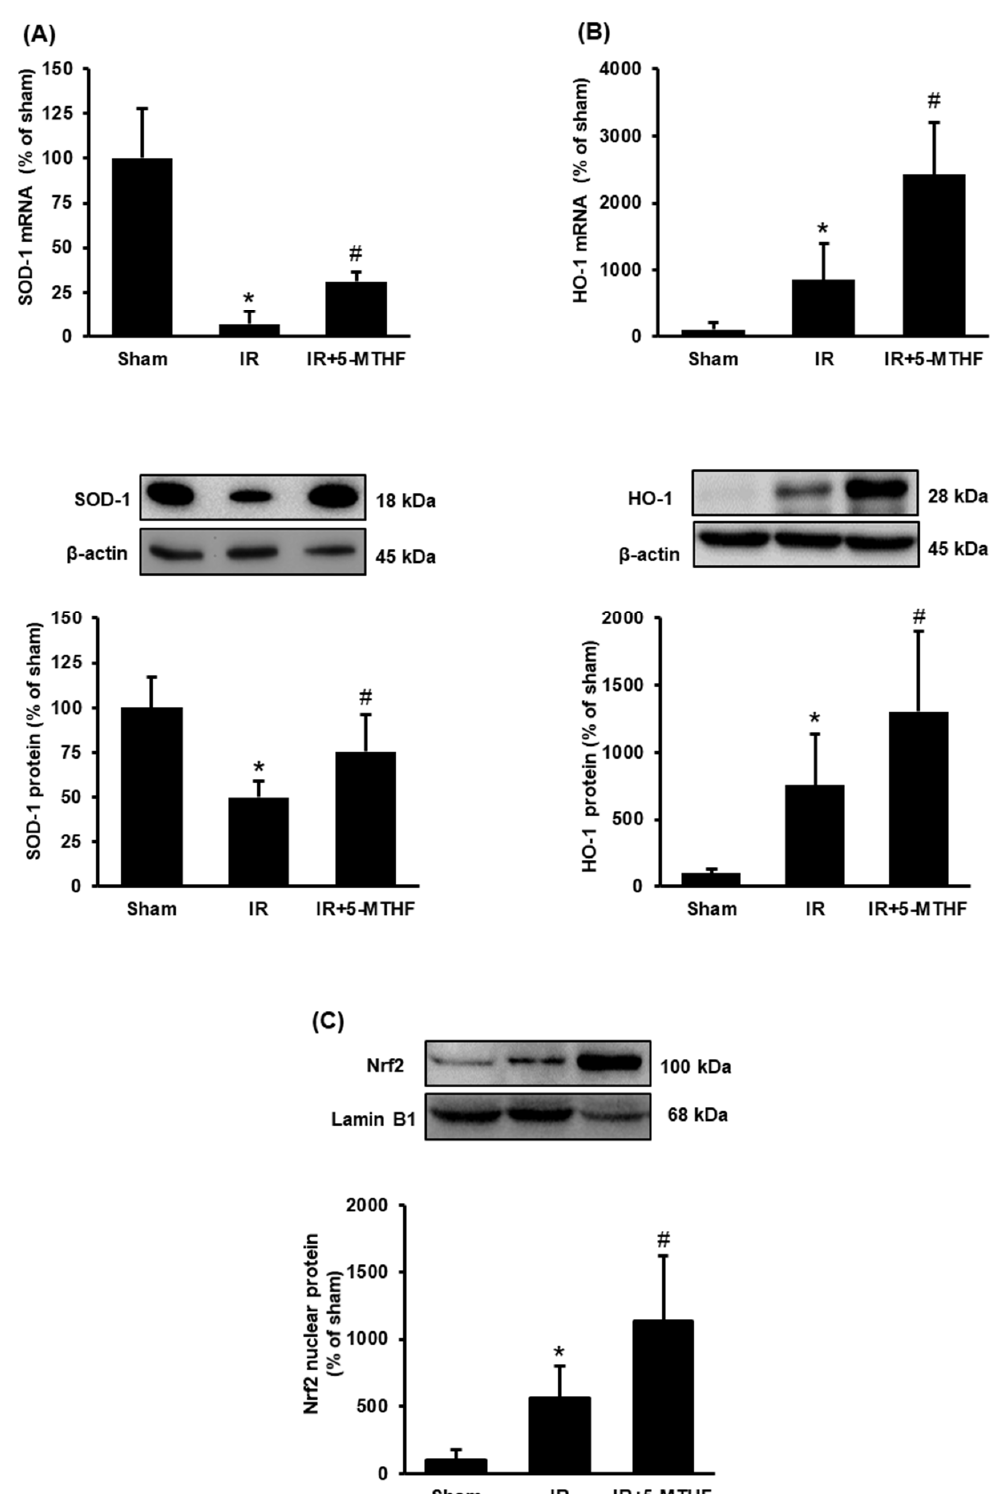
Figure 4. The expression of SOD-1 and HO-1 and Nrf2 in the kidney. Rats were subjected to sham operation (Sham), kidney ischemia-reperfusion (IR) or ischemia-reperfusion with 5-MTHF injection (IR + 5-MTHF). The mRNA and protein expression of ( A ) superoxide dismutase-1 (SOD-1), ( B ) heme oxygenase-1 (HO-1) and ( C ) nuclear Nrf2 protein were measured. Results are expressed as mean ± SD ( n = 5–6). * p < 0.05 when compared with the value obtained from the Sham group. # p < 0.05 when compared with the value obtained from the IR